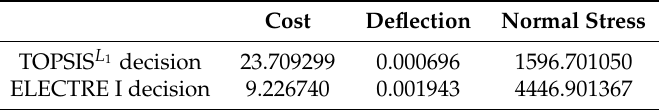
Table 12. Results for the TOPSIS L 1 and ELECTRE I